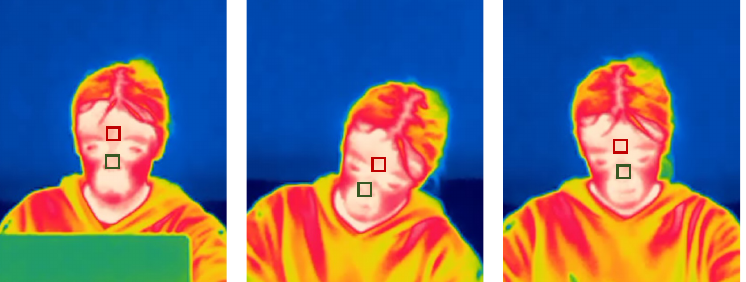
Figure 3. ROI on forehead (red frame) and nose (green frame) of one participant during different